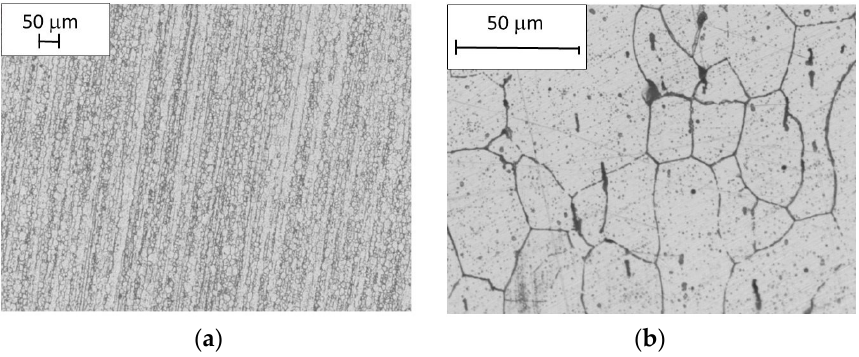
Figure 6. ( a ) Microstructure of the 6082-T6 alloy, BM. Keller etch, 500×; ( b ) Microstructure of 6181-T6 alloy, BM. Keller etch, 100×.